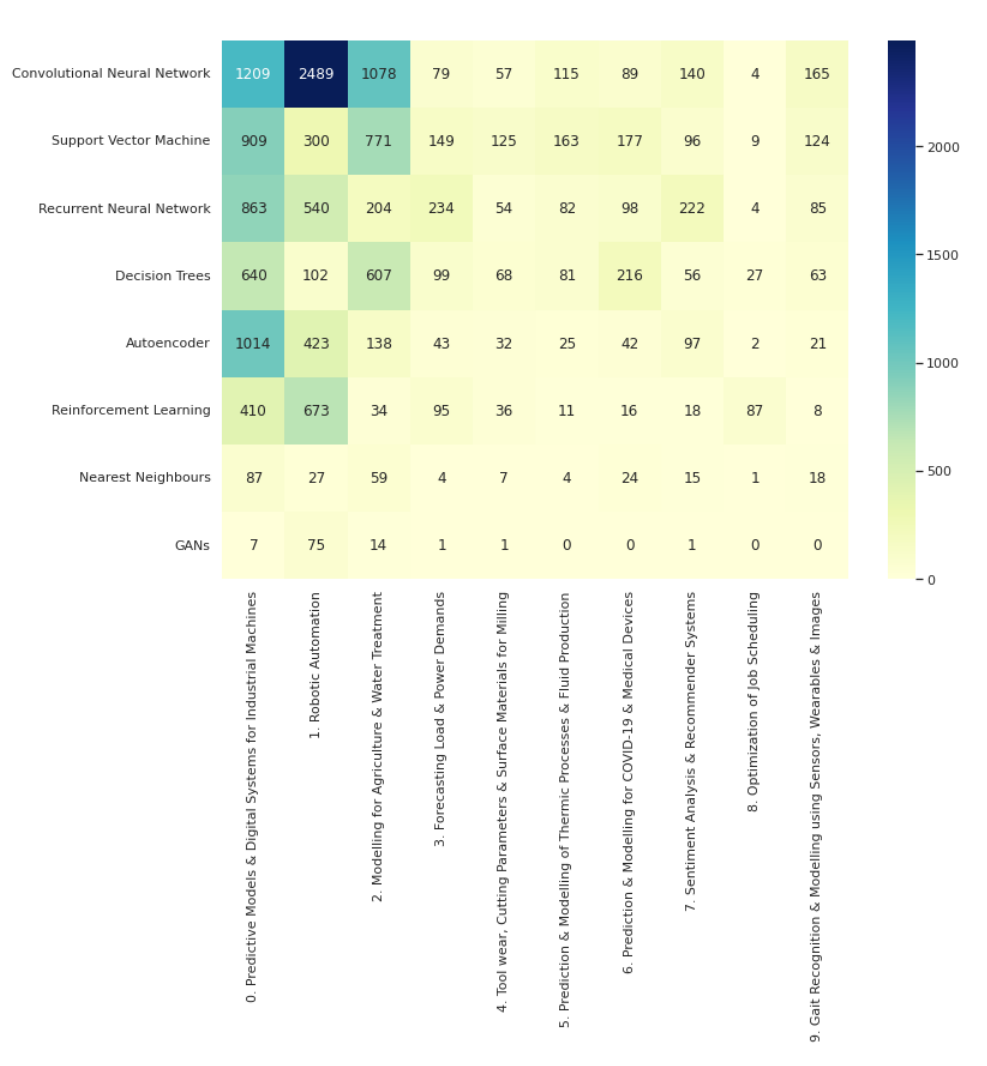
Figure 7. Count of papers by ML term mentions for each